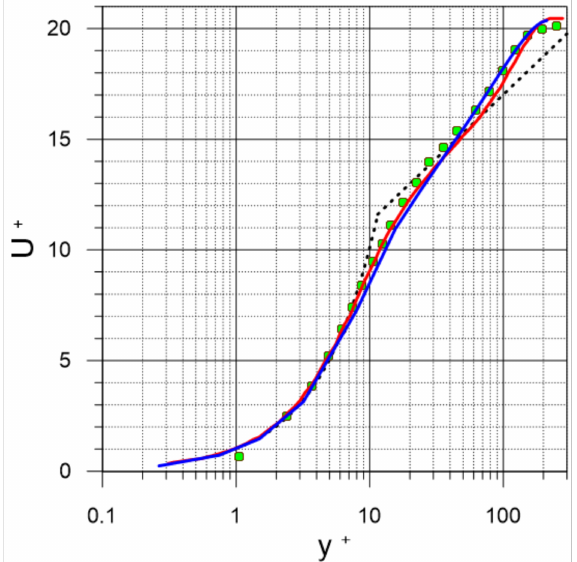
Figure 2. U + (y + ) velocity profile in the boundary layer of turbulent flow; black dashed line = loga- rithmic law; solid red line = DNS (Re θ = 590; [40]); green circles = PIV (Re θ = 518; [41]); solid blue line = RANS (Re θ = 490; this